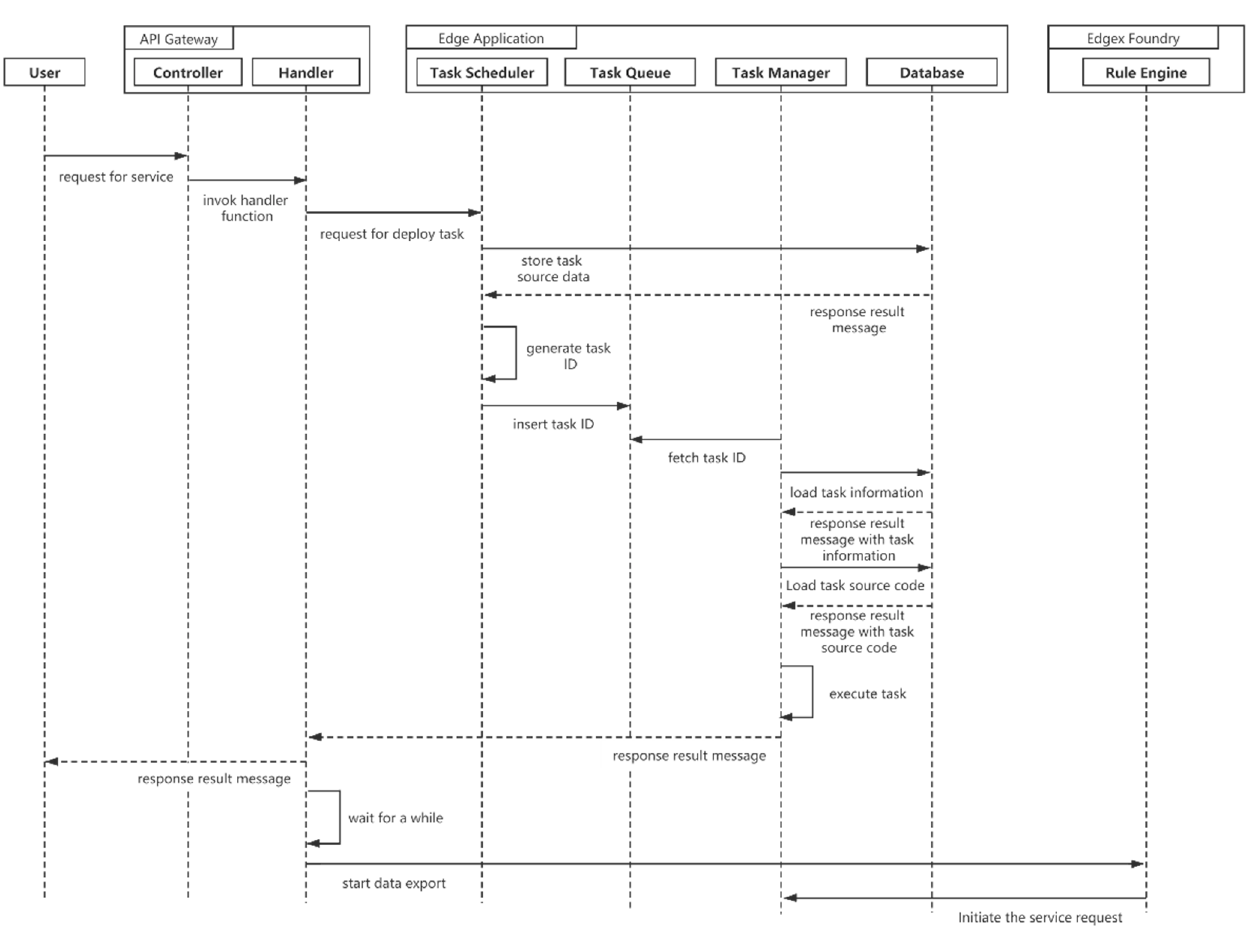
Figure 6. Sequence diagram for smart application binding.